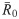
The relationship between R¯0 and the population level attack rate of simulated realisations of the process, across 2011 and 2013 H1N1pdm09.For each accepted particle, the process was simulated again, and the total number of infected individuals from these new realisations was recorded, and converted into an annual attack rate (by dividing by the total population, and by 2 as it is the average over two seasons). Point colour indicates the probability of an individual seeking treatment; larger attack rates correspond to smaller treatment probabilities given that they all fit the same data. The red line shows where the product of R¯0 and the attack rate would be equal to one; this is the line around which the majority of posterior density for initial population susceptibility values was situated (i.e., the density in Fig 4). This can be interpreted as indicating that, for points under this line, not all susceptible individuals became infected during the season.